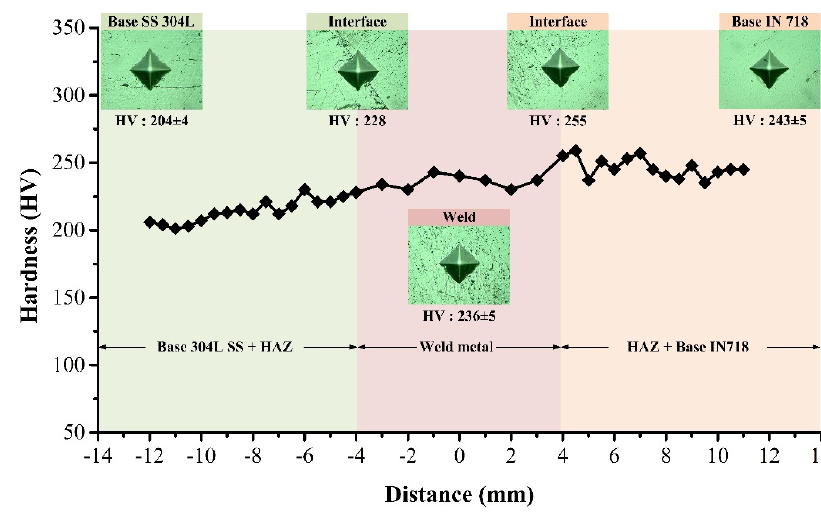
Figure 12. Hardness distribution across dissimilar weldment.